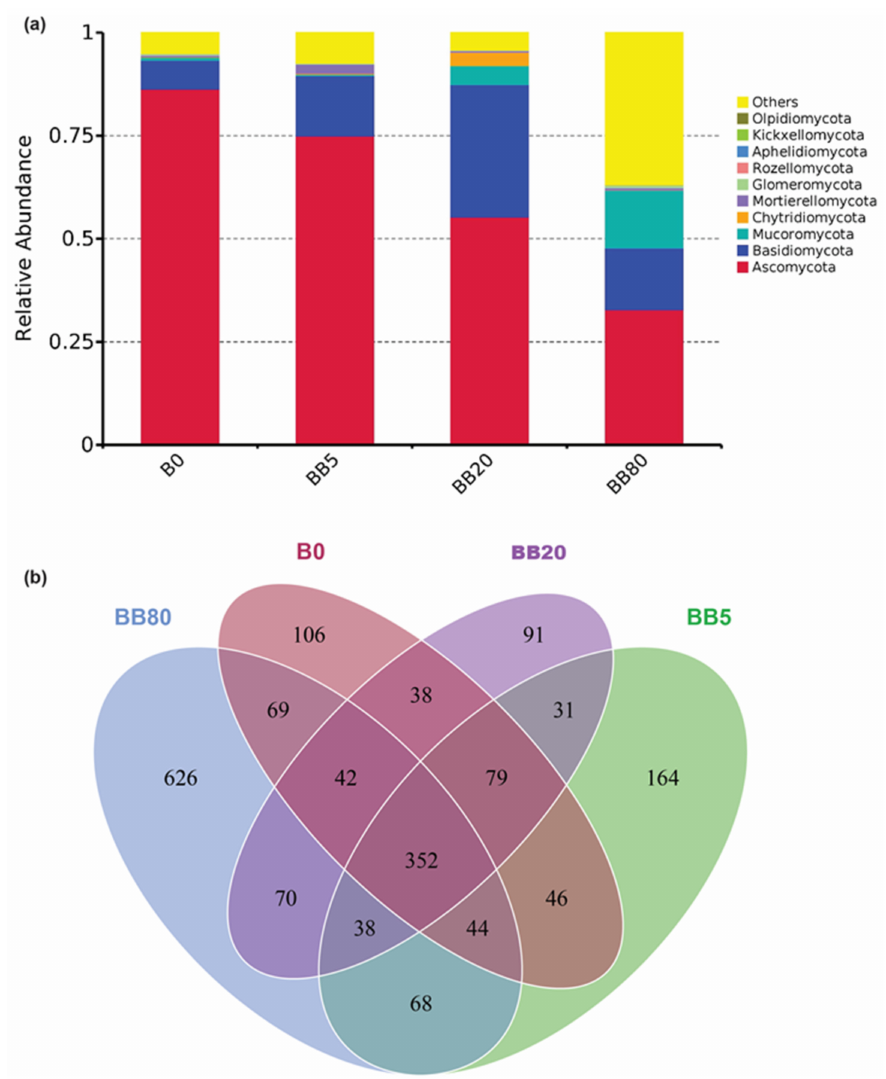
Figure 2. Relative abundance of topsoil fungal species. ( a ) The relative abundance of topsoil fungal communities at Phylum level; ( b ) Comparison of different soil fungal communities under different treatments of bamboo biochar. The relative abundance of the top 10 phyla has been shown and unclassified/less abundant classified as others. B0, BB5, BB20, and BB80 represent different bamboo biochar concentrations of 0, 5, 20, and 80 g kg − 1 ,